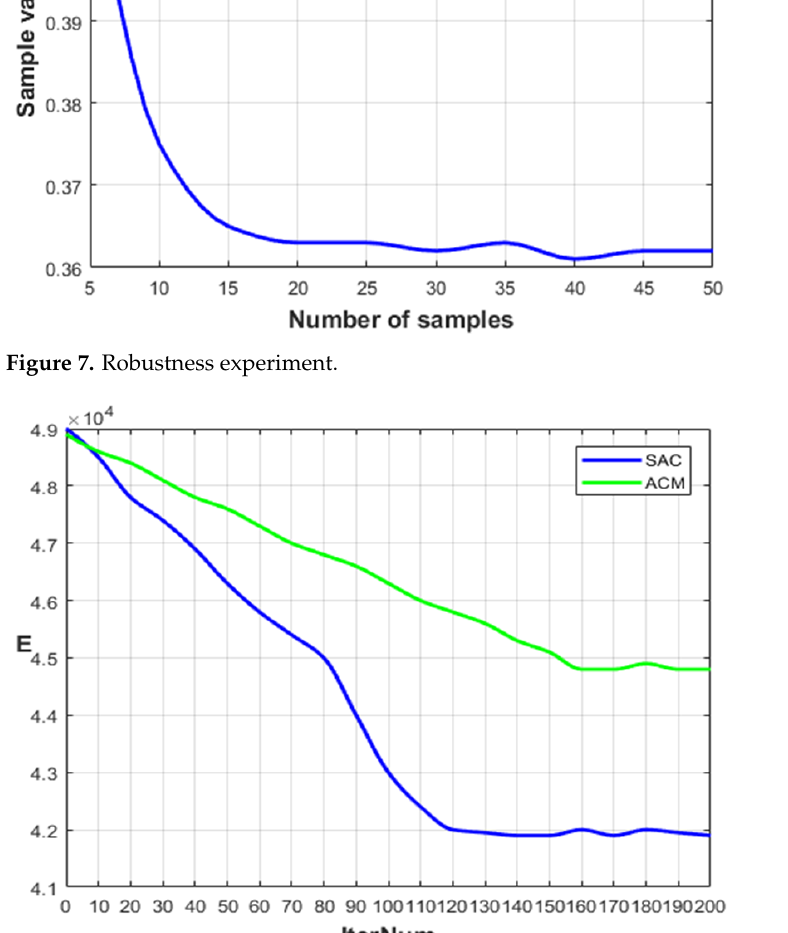
Figure 8. Convergence with/without Brownian